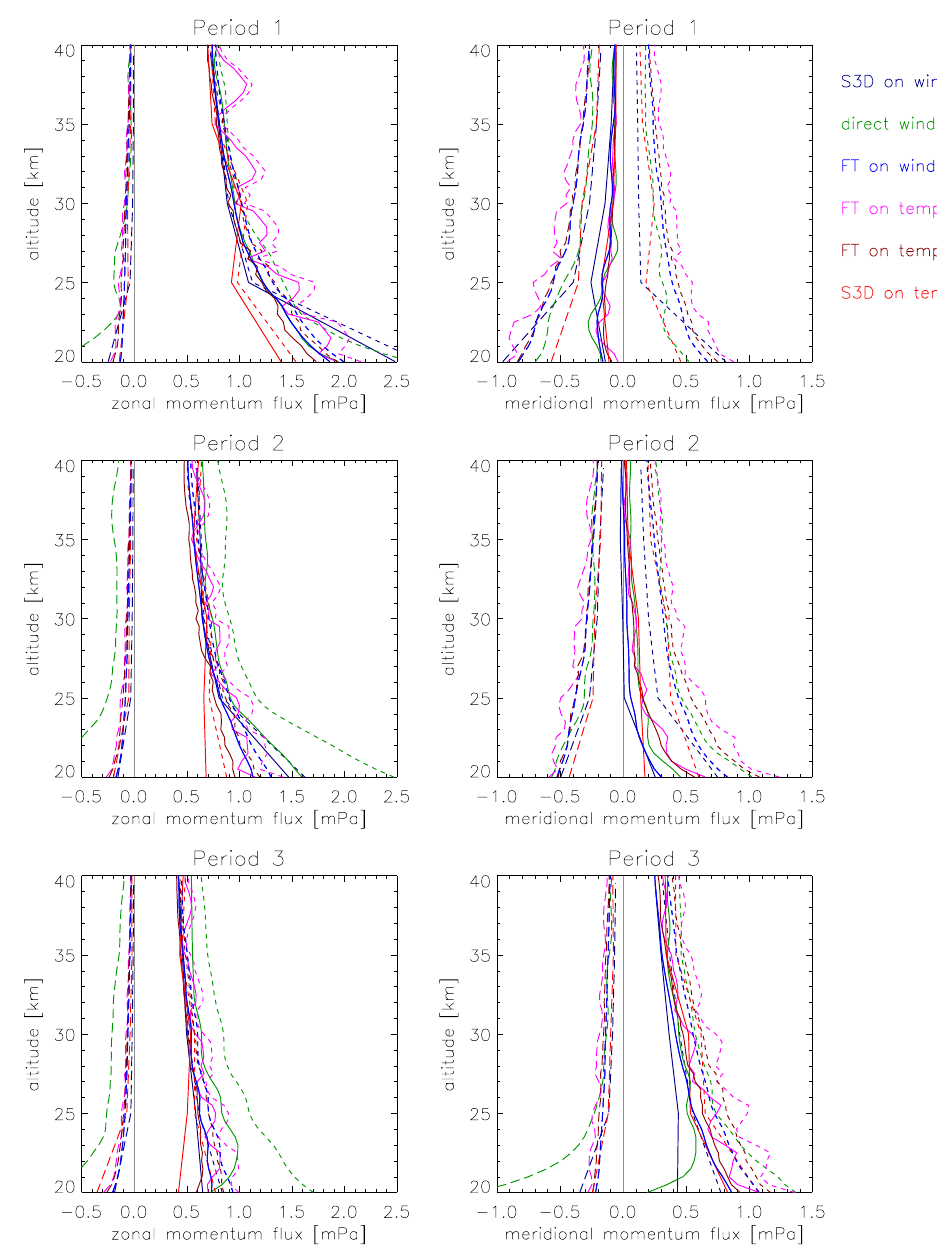
Fig. 2. Comparison of different methods to infer the momentum flux. Shown are results for the three periods and both zonal and meridional momentum. Long-dashed lines indicate negative, dashed lines positive and solid lines net momentum fluxes. Please note that the S3D results are reliable only above